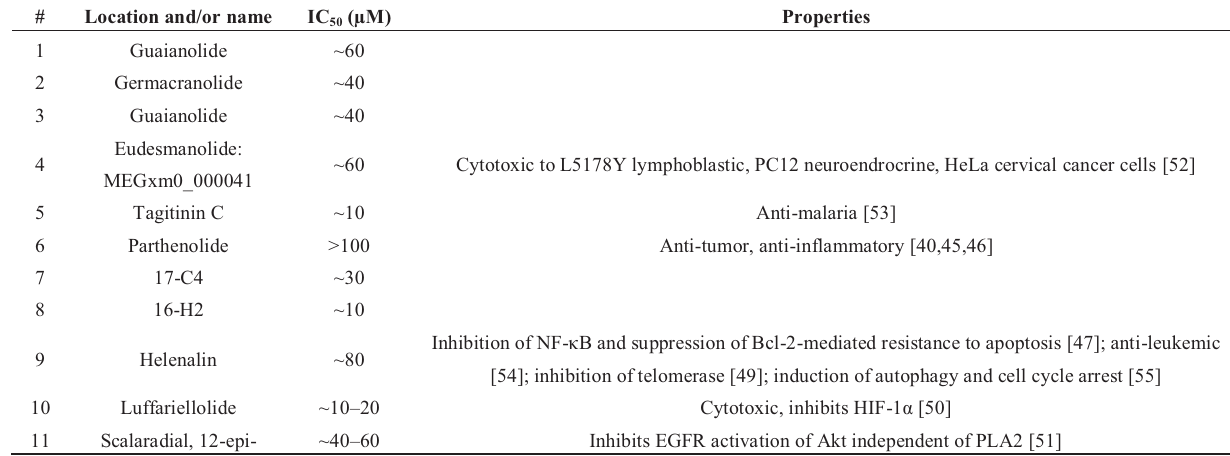
Table 1. Sesquiterpine lactones, tetracyclic sesterpenoids and sesterterpenes.